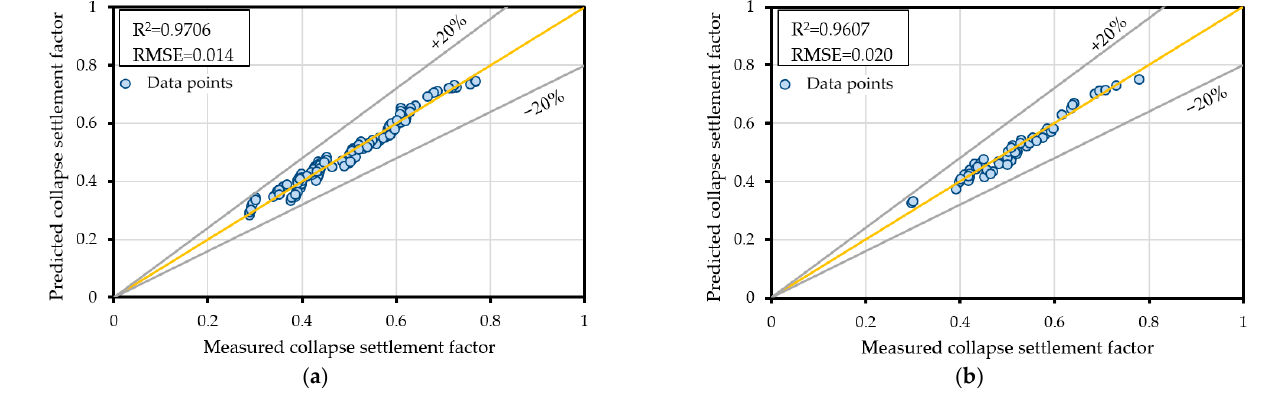
Figure 11. Comparing the results of the predicted and measured coefficient of stress release based on the natural logarithm. ( a ) Training data, ( b ) Testing data.